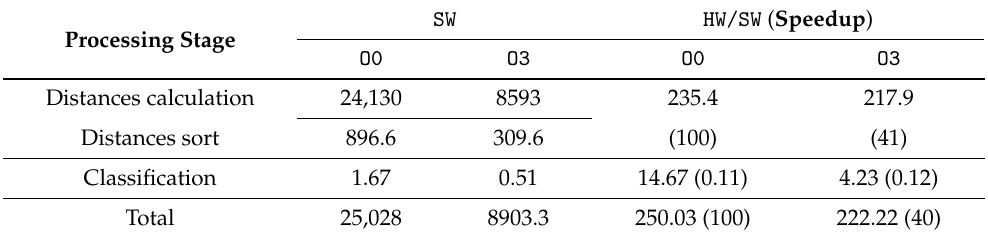
Table 4. Execution times ( µ s) obtained by software-only and hardware/software implementations of the EEG